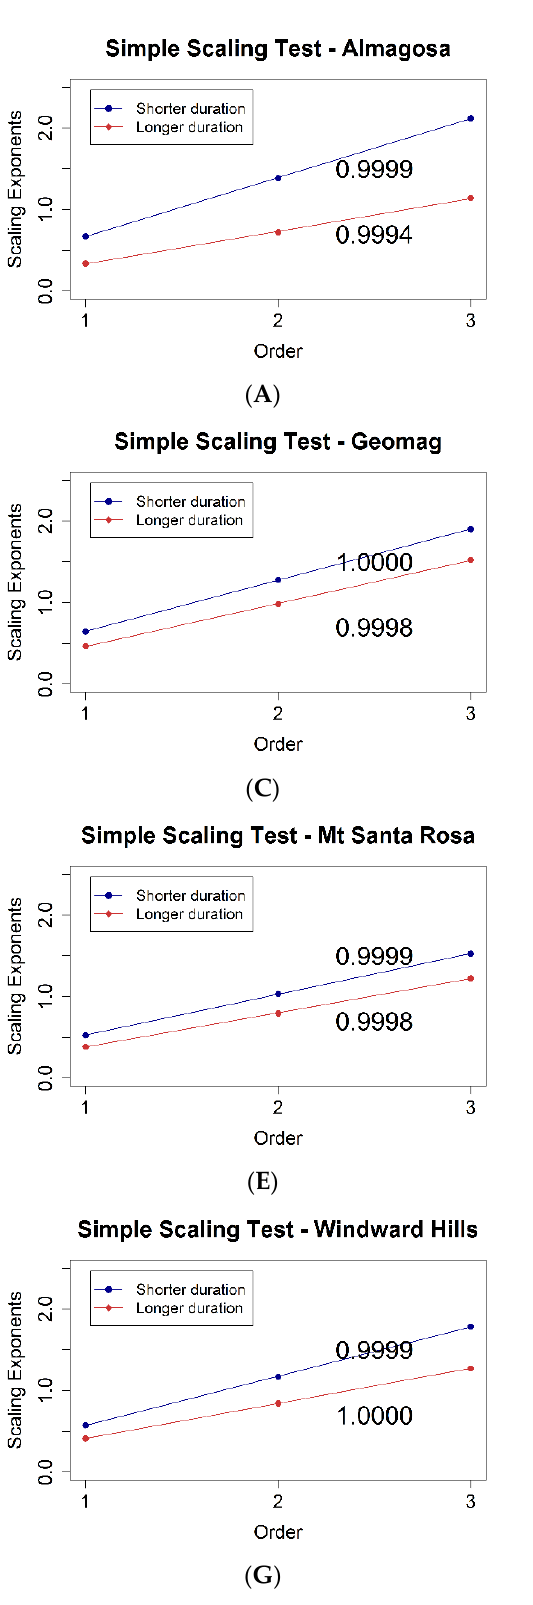
Figure 5. Test of Simple scaling. ( A ) is a plot the scaling exponent against order of NCM of AMPs for Almagosa, ( B ) for Fena Lake, ( C ) for Geomag, ( D ) Mt. Chachao, ( E ) for Mt. Santa Rosa, ( F ) for Umatac, and ( G ) for Windward Hills,